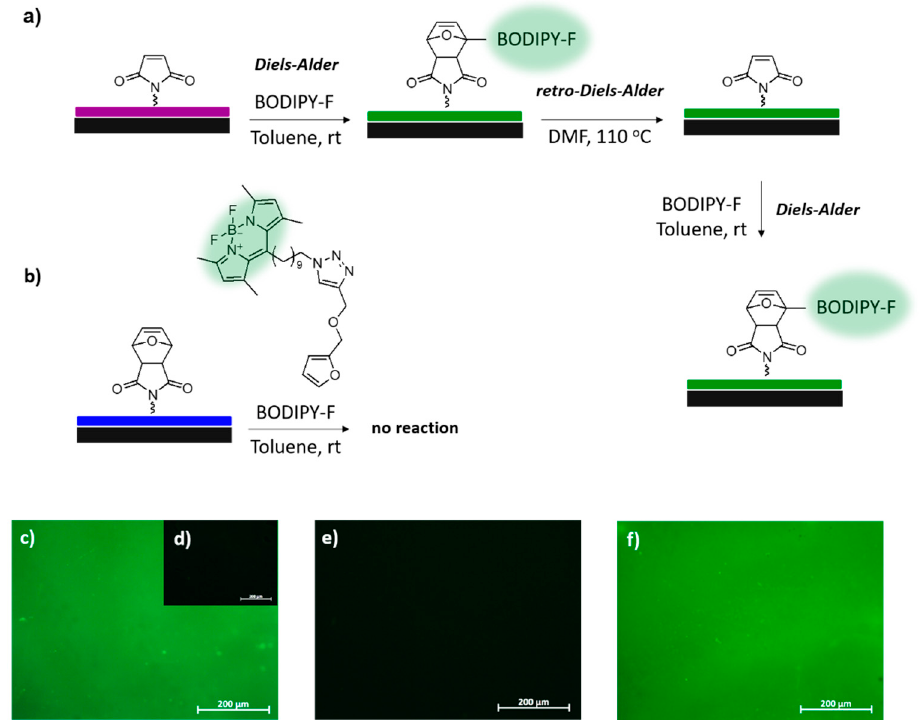
Figure 4. ( a ) BODIPY-F reversible conjugation sequence, ( b ) control reaction. Fluorescence microscopy images of ( c ) dye conjugated hydrogel; ( d ) control experiment; ( e ) hydrogel after dye de-conjugation and ( f ) hydrogel after dye re-conjugation.